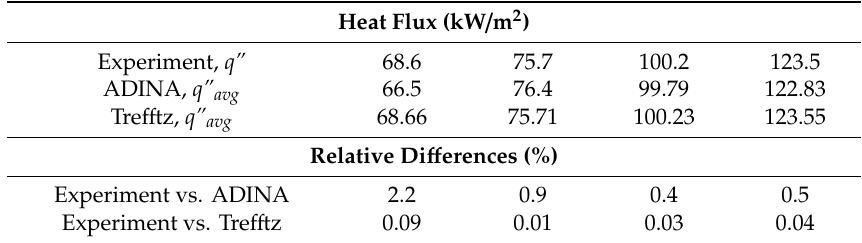
Table 3. The heat flux calculated on the basis of experimental measurements and determined from the 2D approach calculations (average) and relative di ff erences between them, the data for the test section with three